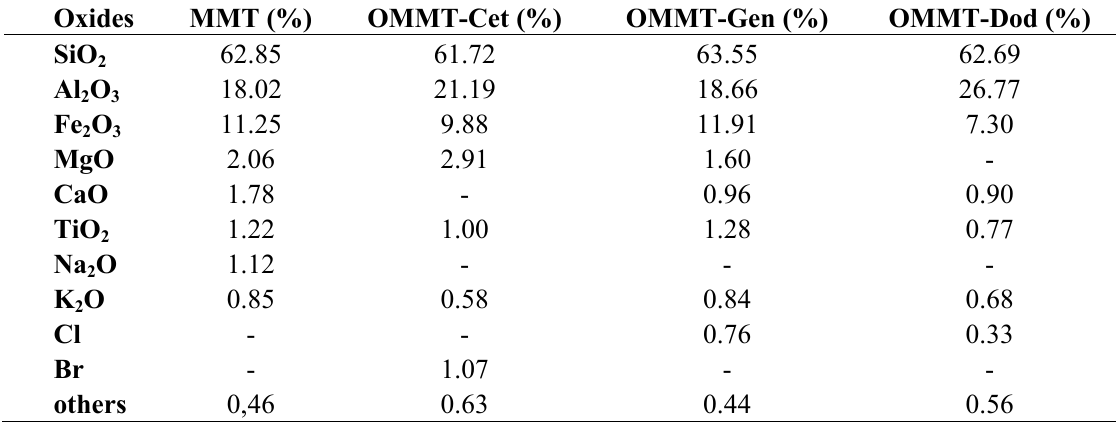
Table 1. Chemical content of unmodified clay (MMT) and organoclay (OMMT) obtained by X-ray